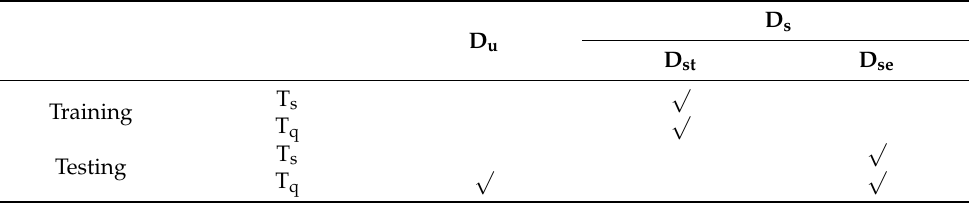
Table 1. Selection mode of T s and T q in training and testing phases (where are they selected from).